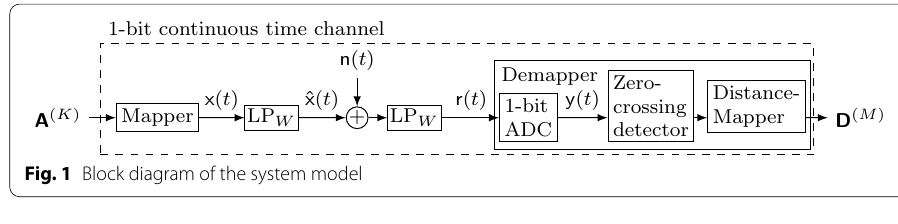
Fig. 1 Block diagram of the system model